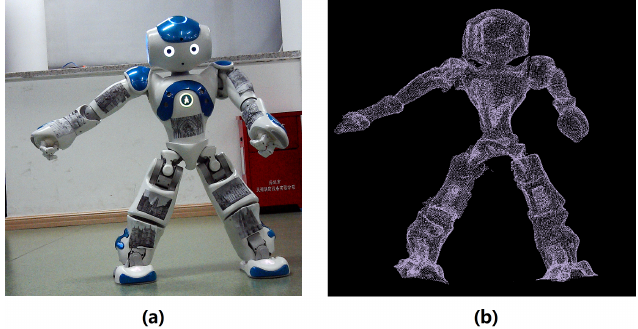
Figure 4. Experiments on a NAO robot. ( a ) shows the robot as the target object to evaluate the algorithms; ( b ) shows the priori model reconstructed at the